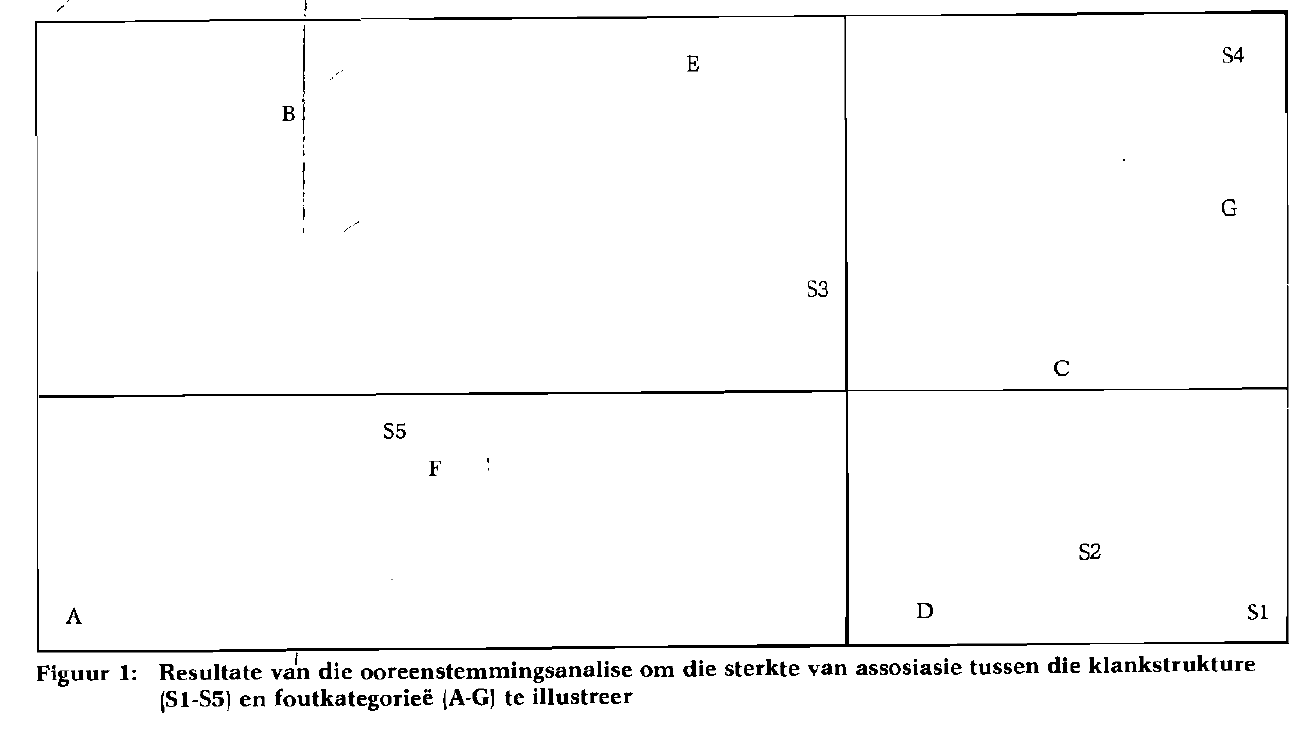
Figuur 1: Resultate van die ooreenstemmingsanalise om die sterkte van assosiasie tussen die